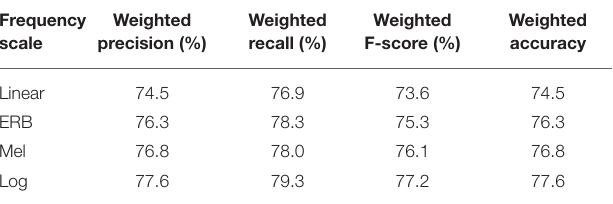
TABLE 4 | Results of Experiment 2—Effect of the reduced bandwidth, the sampling frequency of 8kHz (bandwidth = 4kHz), 7 emotions (anger, happiness, sadness, fear, disgust, boredom, and neutral speech), EMO-DB database.